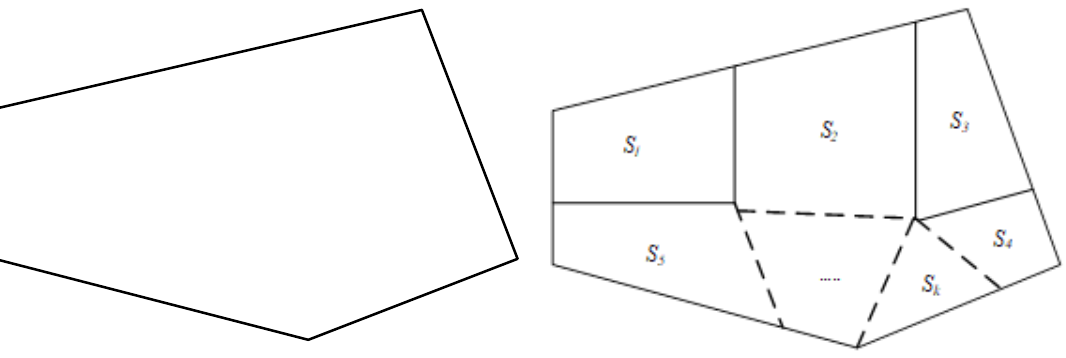
Figure 3. Preliminary division of decision area of VPP.